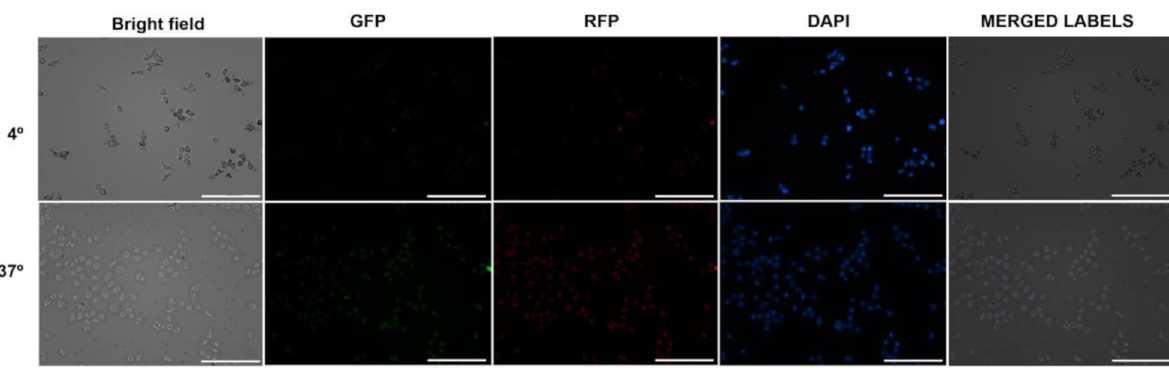
Figure 10. Microscopies (10 × ) of HaCaT cells after 4 h of incubation with F-UDL-Vis at 4 ◦ C (upper images) and 37 ◦ C (lower images). Green, red, and blue signals correspond to TopFluor ® cholesterol, propidium iodide, and DAPI, respectively. Filter cubes used to detect each fluorophore are indicated. Scale bar corresponds to 200 µ